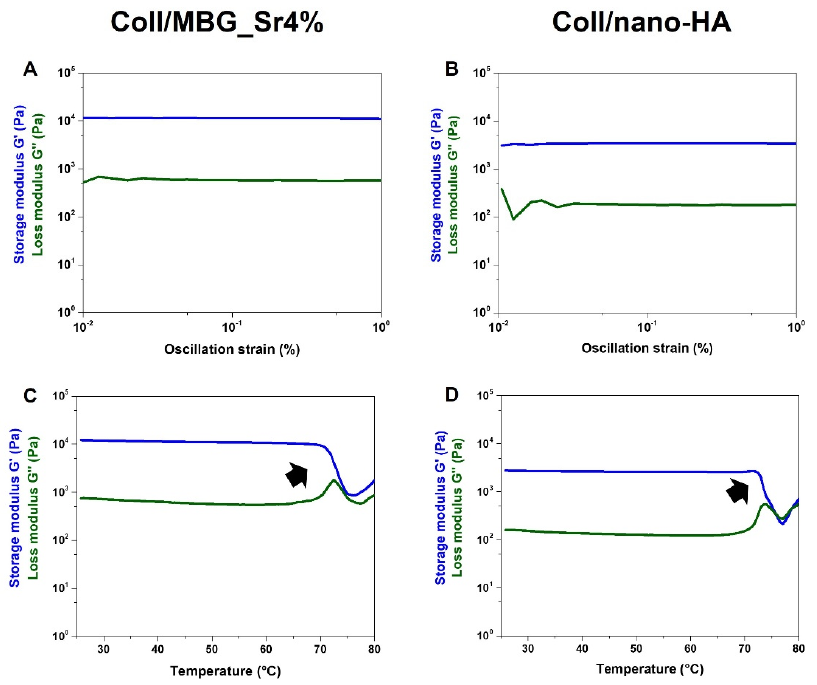
Figure 3. Viscoelastic properties of the composite systems: material strength ( A , B ) and denaturation temperature ( C , D ).